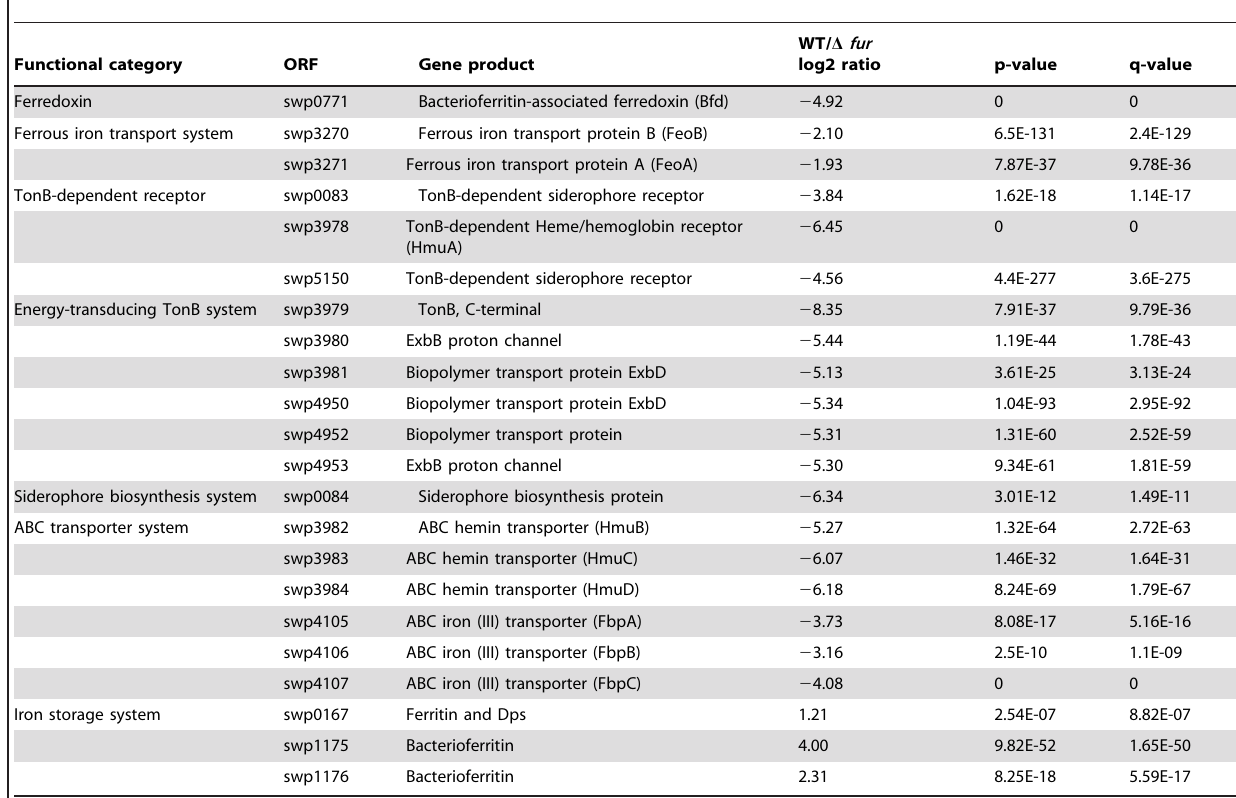
Table 2. Fur-responsive modules for iron acquisition and storage systems with fumarate as the EA.